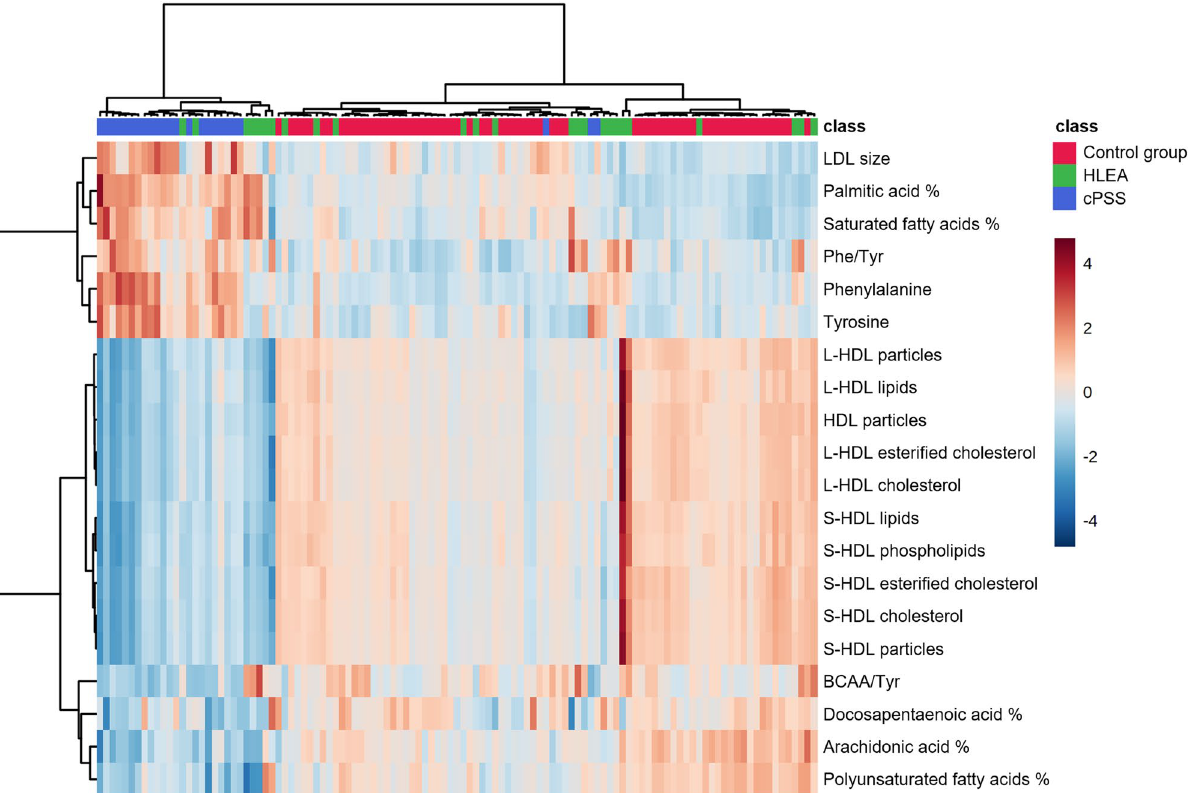
Figure 5. Hierarchical cluster heatmap (for samples and variables) of serum metabolomic results using the top 20 parameters identified by partial least squares-discriminant analysis (PLS-DA) variable importance in projection (VIP) scores. Each column represents one serum sample with group marking colored at the top: blue cPSS (n = 24), green HLEA (n = 25), and red Control group (n = 64). The colored legend on the right indicates the relative metabolite concentrations, with different red and blue intensities indicating high and low values, respectively. Horizontal and vertical black lines depict clustering of samples and